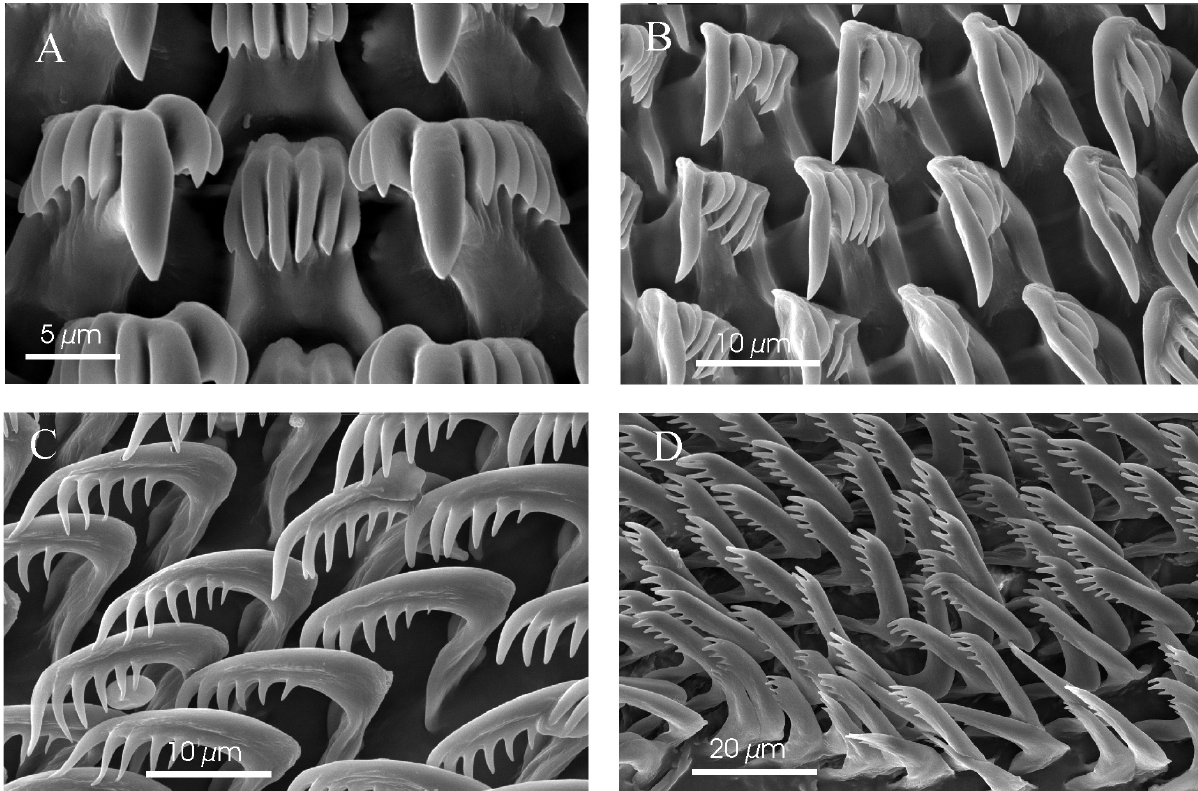
Cadlina evelinae Er. Marcus, 1958, pp. 18-21, Figs. 28-33. Material examined. (Length in living animals): 3 specimens of length 8, 7.5 and 3 mm, Praia dos Ossos (Buzios, Rio de Janeiro), intertidal (03/07/99); 1 specimen of length 7.5 mm, Armaçao (Buzios, Rio de Janeiro), intertidal (22/06/00); 5 specimens of length 12, 9.5, 5.5, 5 and 3.5 mm, Manguinhos (Buzios, Rio de Janeiro), intertidal (23/06/00); 1 specimen of length 9 mm, Praia dos Ossos (Buzios, Rio de Janeiro), intertidal (24/06/00); 1 speci- men of length 7 mm, Praia dos Ossos (Buzios, Rio de Janeiro), intertidal (24/06/00). External morphology . Elongated white translu- cent body; mantle edge and foot have a thin white line (Fig. 1C). There are numerous dark orange-yel- low spots over the dorsum; some specimens have bigger and more numerous spots on the mantle edges. There are five white bipinnated gills, the pos- terior ones smaller than the anterior